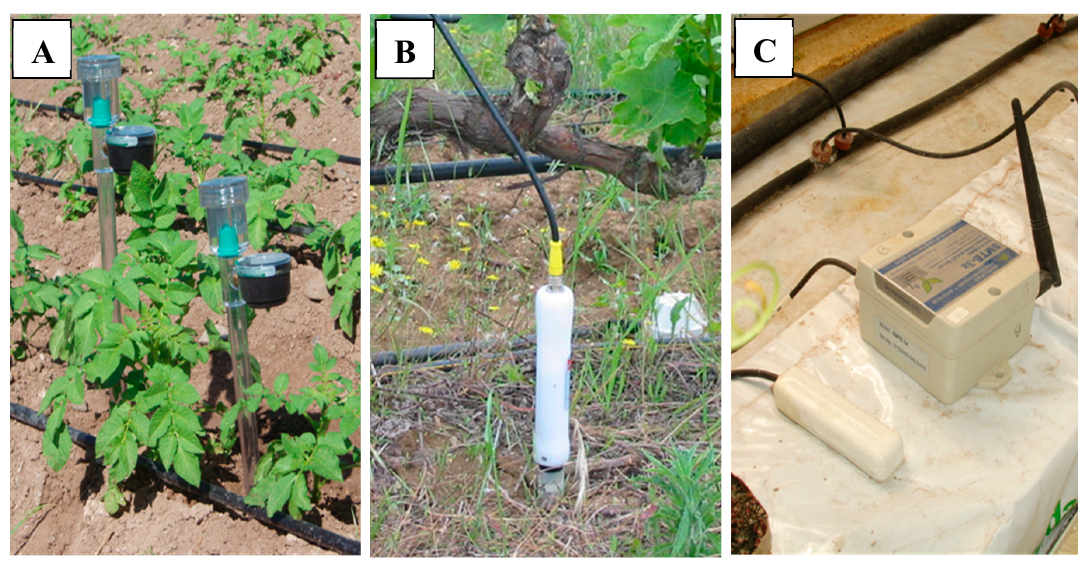
Figure 5. Devices for monitoring the soil water content; a pair of manual reading tensiometers installed in a potato crop ( A ), analog tensiometer installed in a vine open-field crop (( B ); source: ScientAct S.A., Thessaloniki) and a wireless time domain reflectometry sensor installed in soilless media ( C ).